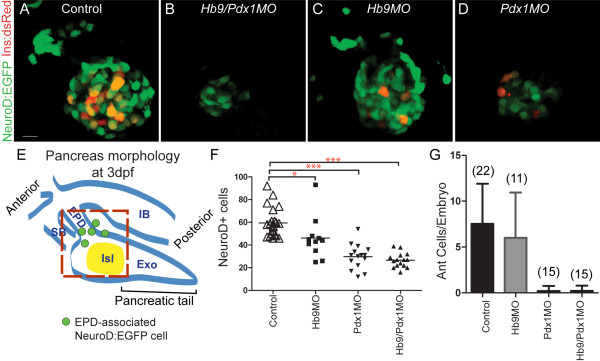
Absence of ventral bud endocrine precursors in hb9/pdx1 and pdx1 morphant embryos. (A-D) Projections of confocal stacks showing native fluorescence of 3 days post fertilization (dpf) TgBAC(NeuroD:EGFP)nl1; Tg(ins:dsRed)m1018 embryos. In uninjected control embryos (A) and in hb9 morphants (C), enhanced green fluorescent protein (EGFP)+ cells are found in the islet and in smaller numbers also anterior to the islet. In hb9/pdx1 double morphants (B) and pdx1 morphants (D), the number of islet-associated EGFP+ cells is strongly reduced and anterior cells are missing. Few Ins:DsRed cells are present in pdx1 single morphants at 3 dpf (D), reflecting slow maturation of the DsRed fluorophore. (E) Schematic of pancreas morphology at 3 dpf. The principal islet (Isl) at this stage is primarily dorsal bud derived. The ventral bud contributes new NeuroD:EGFP cells (green circles), and generates exocrine pancreas (Exo) and extrapancreatic duct (EPD). IB, intestinal bulb; SB, swim bladder. Red box delineates region included for quantitation of islet and newly emerging anterior endocrine cells. (F) Quantitation of pancreatic EGFP+ cells (*P < 0.05, ***P < 0.001 with P values determined using one-way analysis of variance (ANOVA) with Bonferroni's post test). (G) Quantitation of anteriorly positioned EGFP+ cells in uninjected and morpholino injected embryos (error bars indicate standard deviation from the mean). Scale bar = 10 μM.